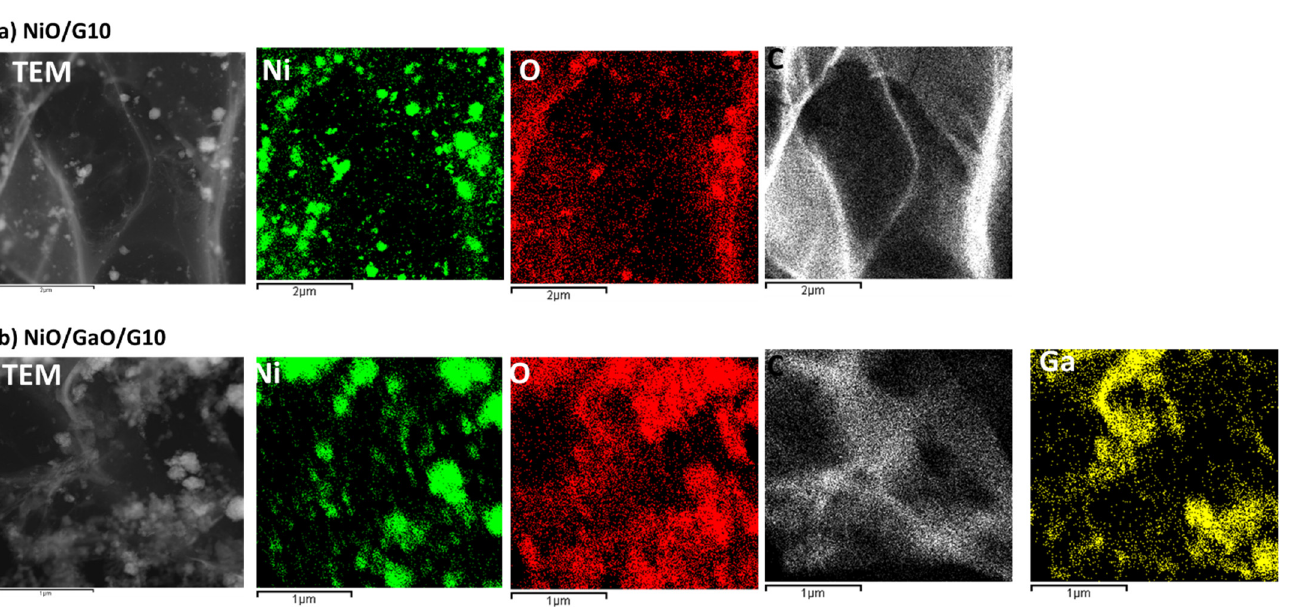
Figure 3. EDX-mapping for the distribution of Ni, Ga, O, and C elements for ( a ) NiO/G10, and ( b ) NiO/Ga 2 O 2 /G10 nanocomposites.